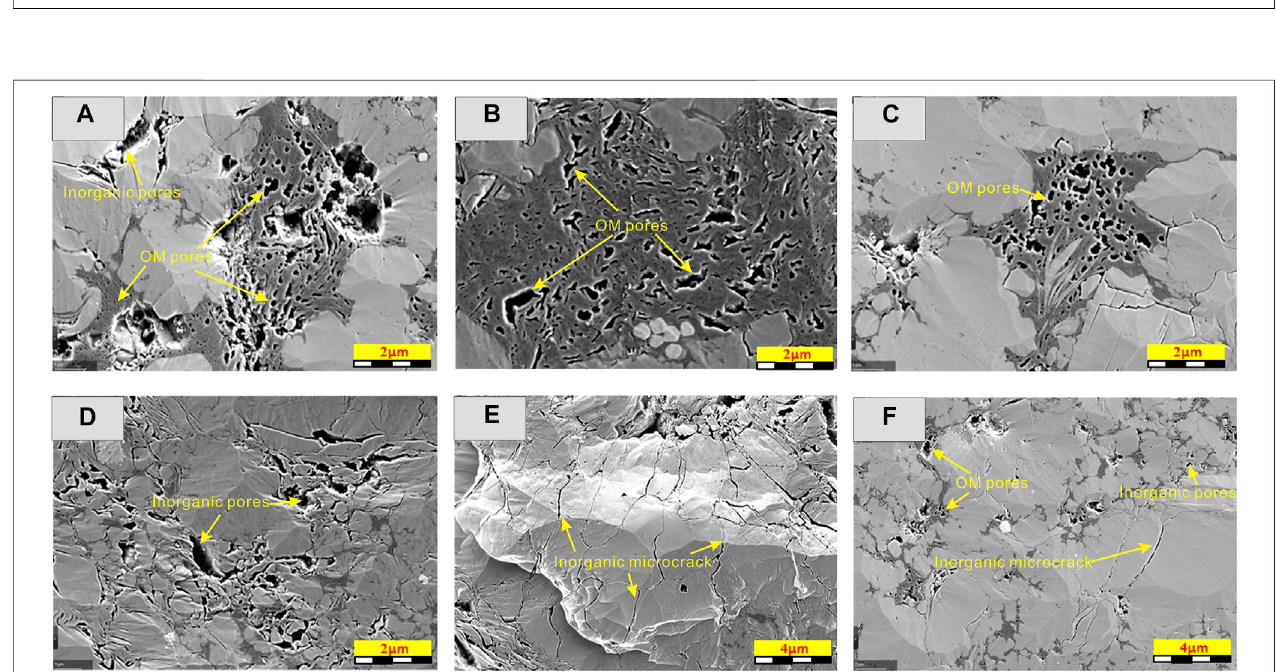
FIGURE 2 | Photographs of scanning electron microscopy (SEM) of the Wufeng – Longmaxi Formation shale; (A) inorganic pores and organic matter pores from L203well, (B) organicmatterporesfromL205well, (C) organicmatterporesfromL207well, (D) inorganicporesfromL209well, (E) inorganicmicrocrackfromL206well, and (F) inorganic pores, microcracks, and organic matter pores from L208 well.